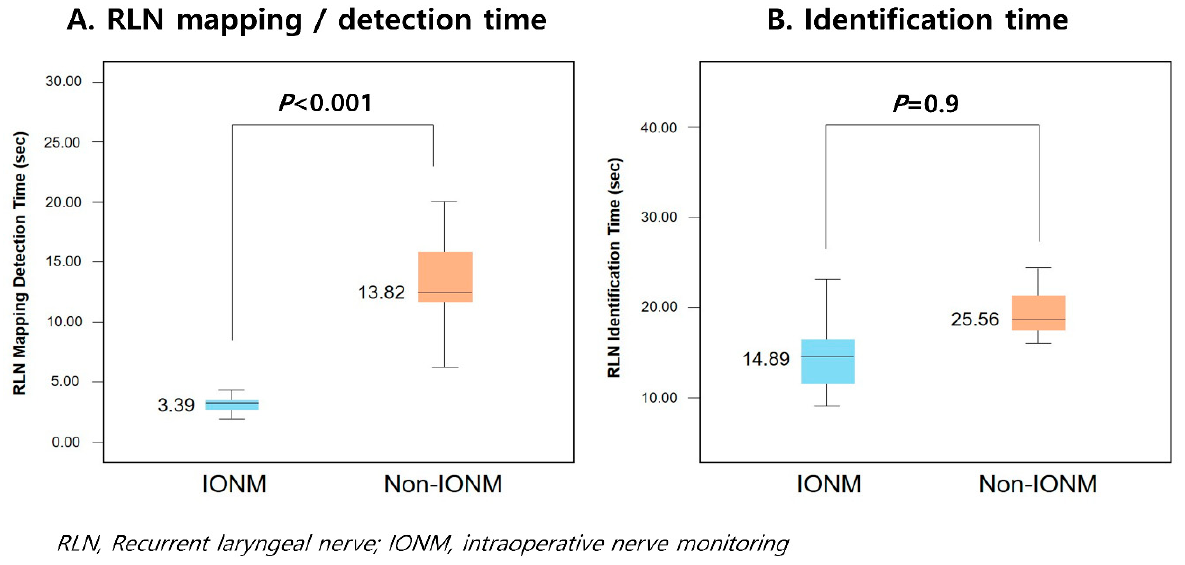
Table 1. Demographic characteristics of IONM * and non-IONM * groups. Characteristics